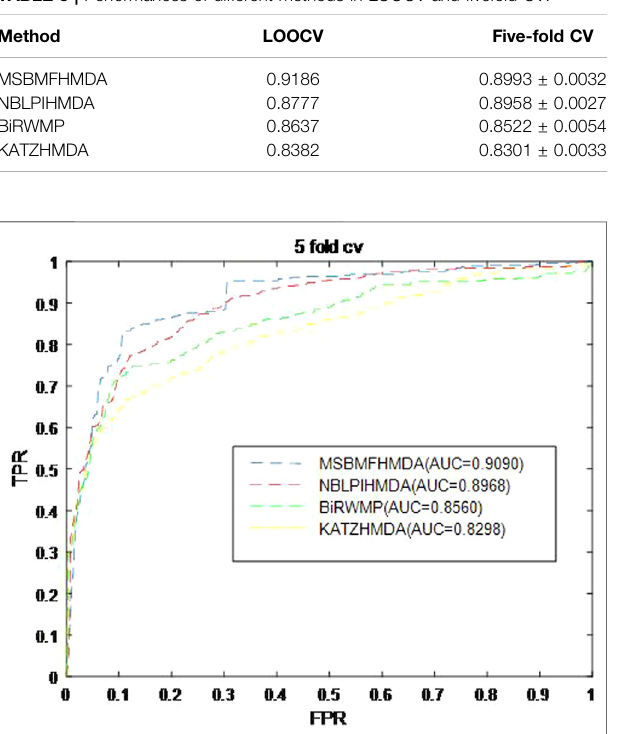
Frontiers in Genetics |